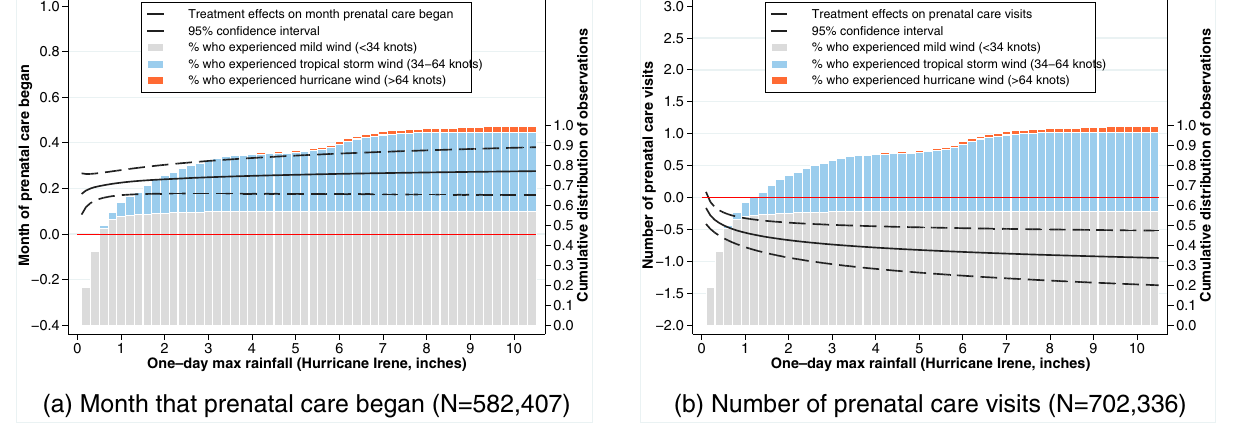
the hurricane event ’ s impact on North Carolina. Estimated treatment effects were overlayedwithacumulativedistributionofwindspeedexposures.Rainfallsource: Parameter-elevation Regressions on Independent Slopes Model (PRISM) climate group Time Series Values for Individual Locations. Source data are provided as a Source Data fi